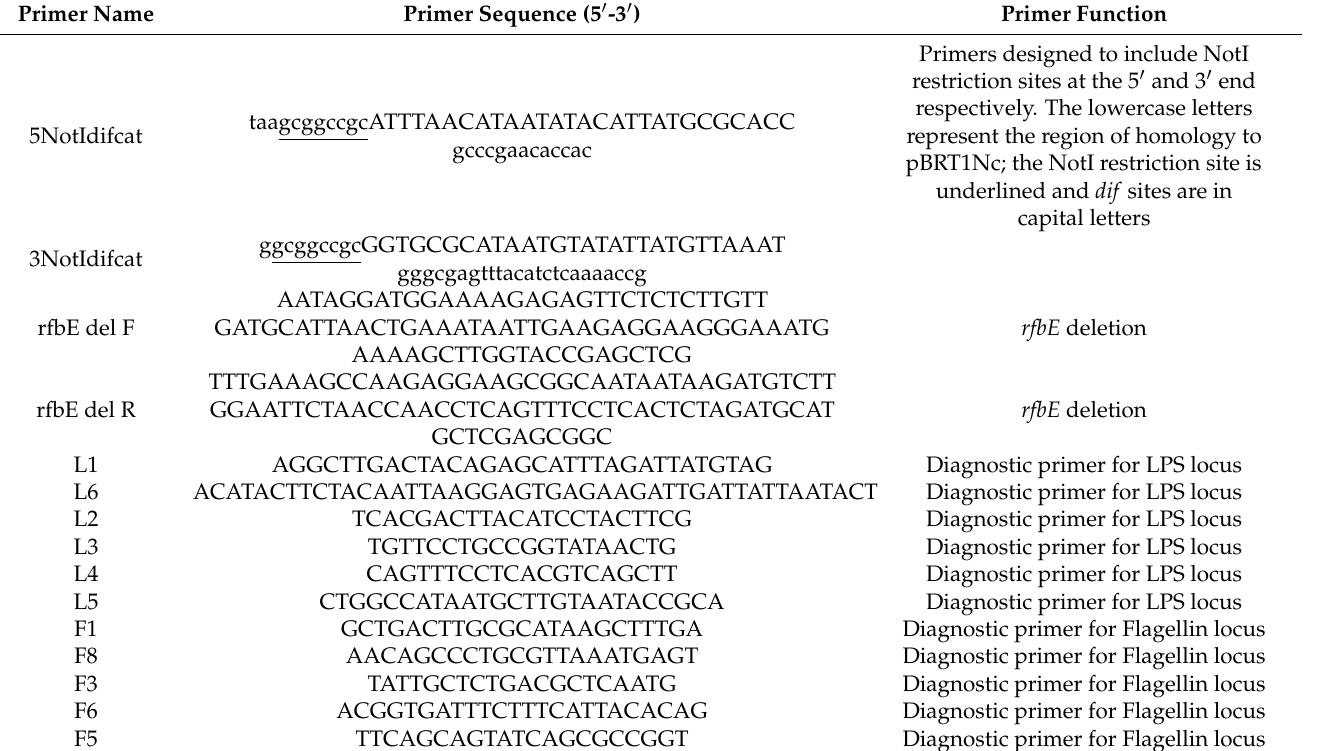
Table 2. PCR and sequencing primers used in this